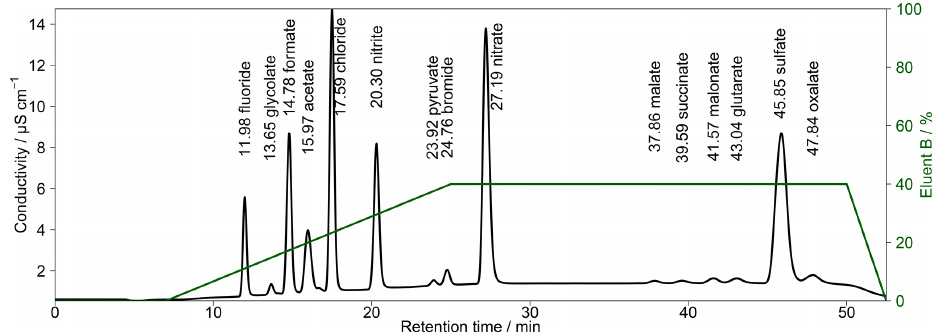
Figure 5. Chromatogram of combined Metrosep A Supp 16 250 and 150mm columns with a gradient eluent. The concentrations of the stan- dard solution are 50µgL − 1 for Cl − , NO − , formate and acetate; 100µgL − 1 for NO − and SO 2 − ; and 10µgL − 1 for F − , Br − and all organic 2 3 4 acids. Numbers in front of the ion names indicate the retention times in minutes. The fraction of eluent B within the eluent mixture over time is given as the green line. The eluent concentration of A is 0.5mM Na 2 CO 3 / 0.75mM NaOH and of B is 20mM Na 2 CO 3 / 0.75mM NaOH. T = 65 ◦ C and eluent flow is 0.8mLmin − 1 .